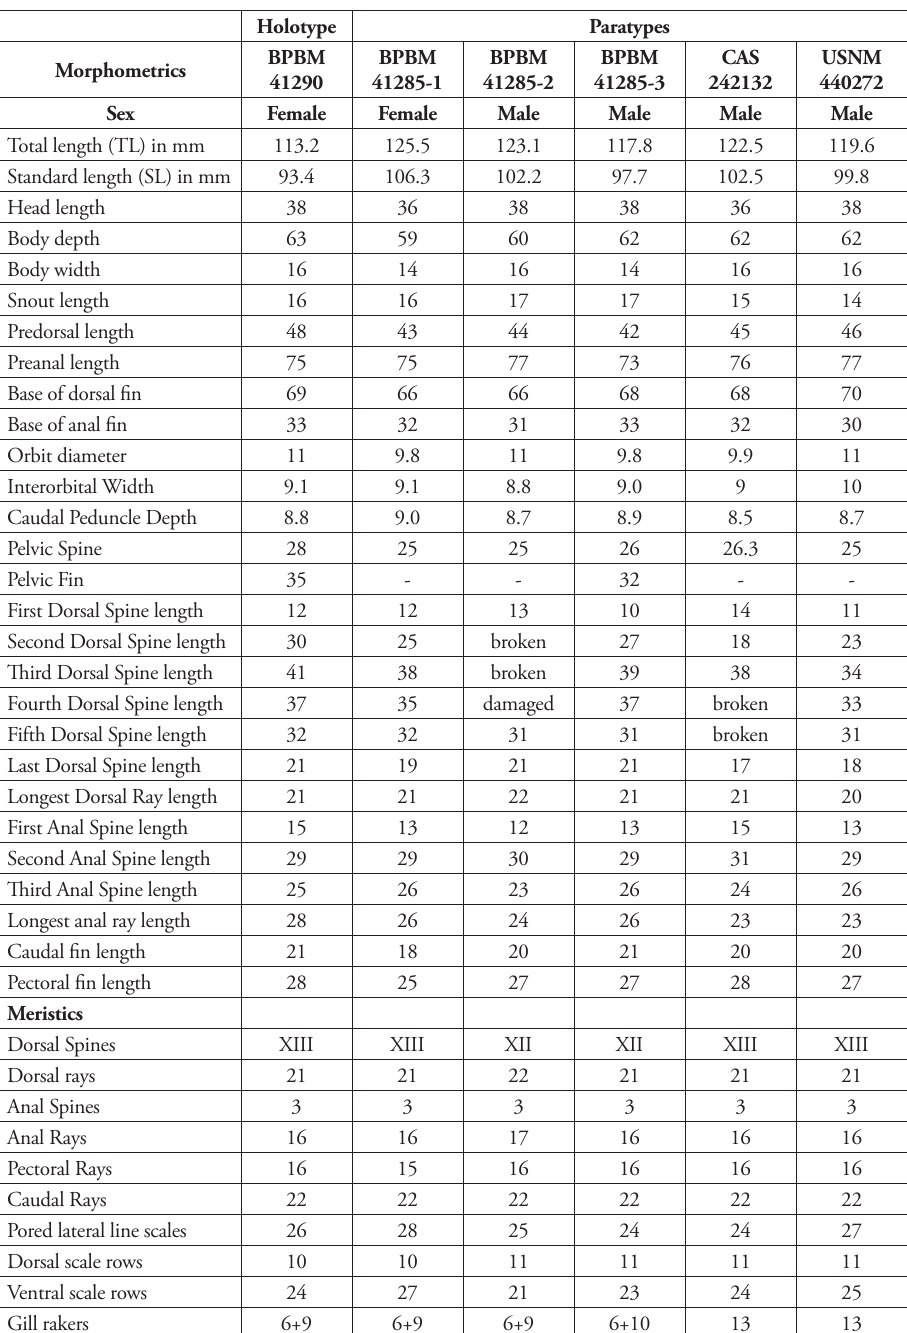
Table 1. Morphometric and meristic data for selected characters of type specimens of Prognathodes basabei . Values of morphometric data (other than TL and SL) are represented as % of